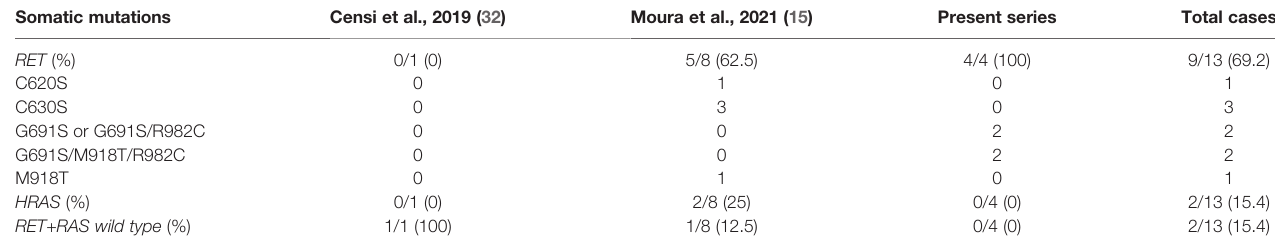
TABLE 5 | RET and RAS genes mutational status in encapsulated MTC samples from previously published studies and present series. Somatic mutations Censi et al., 2019